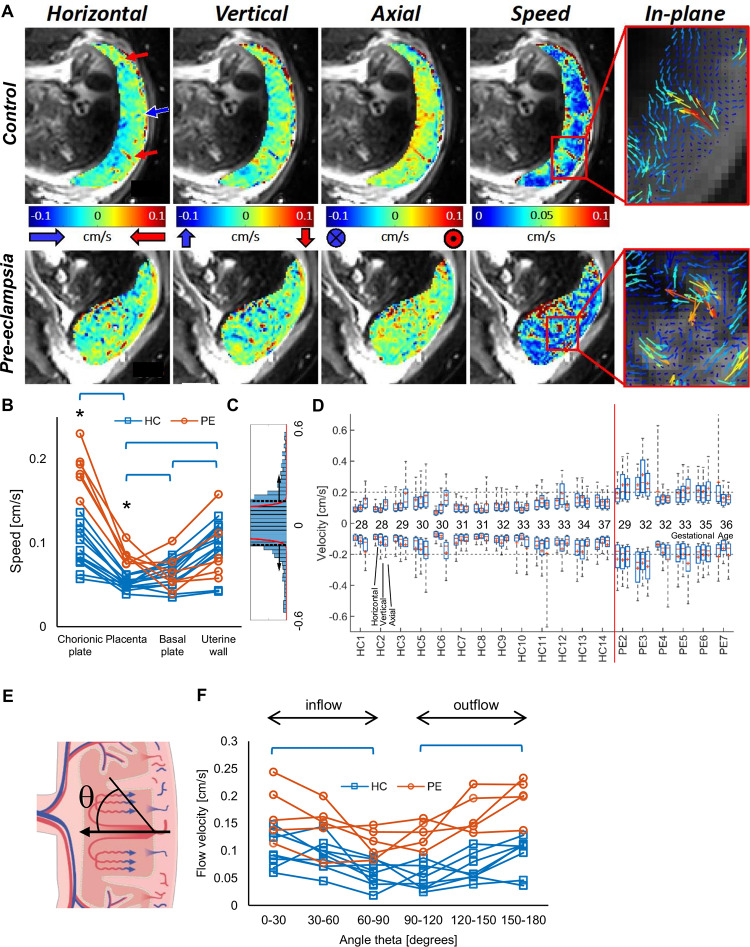
Net velocity of flow through the placenta.(A) Maps of velocity across the placenta for participants HC3 (top) and PE6 (bottom) showing velocity in three orthogonal directions, net speed (|v|), and quiver plots that illustrate the direction and magnitude of blood flow within the imaging plane. (B) Speed of blood movement averaged across each ROI for each participant (* indicates significant difference between HC and PE; brackets indicate significant difference between ROIs for HC participants only; S3 Table). (C) The distribution of one component of velocity across the placental ROI for one HC, magnified to illustrate the tails of the histogram. The red curve indicates a normal distribution fitted to data within one standard deviation of the full histogram, and the dashed lines indicate four standard deviations from the centre of that fitted peak; voxels beyond these dashed lines were identified as fast-moving voxels. (D) The median (−), mean (+), interquartile range (box), and absolute range of the horizontal, vertical, and axial velocity in these fast-moving voxels. (E) The velocity of flow within the placenta in a narrow band adjacent to the basal plate, binned by direction of flow with respect to the normal to the basal plate, (F) showing that the highest velocities are perpendicular to the basal plate for both inflow and outflow. Underlying data plotted in panels B, D, and F are provided in S1 Data. HC, healthy control pregnancy; PE, preeclamptic pregnancy; ROI, region of interest.